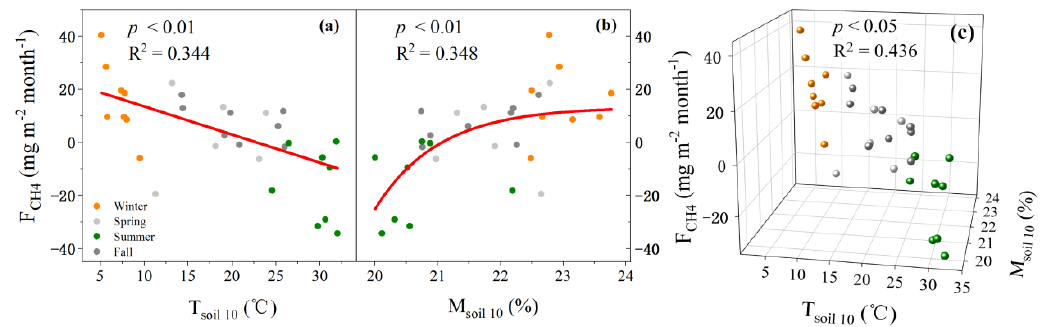
Figure 6. Correlations between monthly CH 4 flux (mg m − 2 month − 1 ) and ( a ) soil temperature at 10 cm of soil depth (T soil10 ) and ( b ) soil moisture at 10 cm soil depth (M soil10 ) and the three-dimensional scatter plot ( c ) between monthly CH 4 flux and T soil10 and M soil10 .